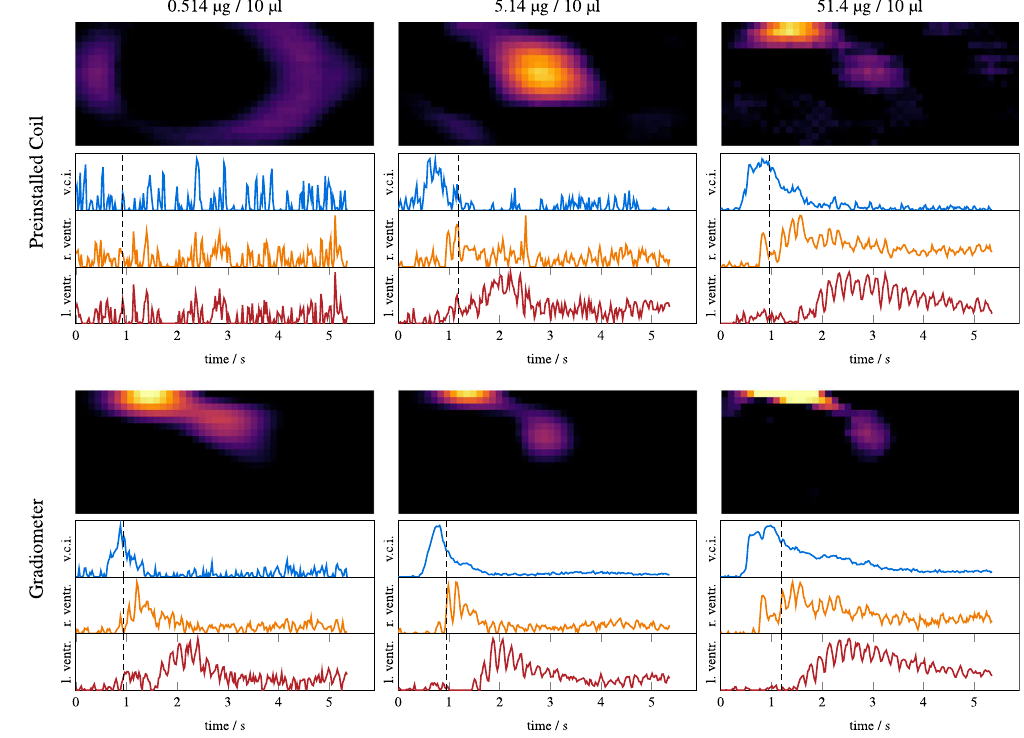
Figure 8. In vivo reconstruction results of the mouse experiment with three different boli: 514 ng/10 μ L (left), 5.14 μ g/10 μ L (middle), 51.4 μ g/10 μ L (right). The results for the preinstalled coil are shown at the top while the results obtained with the gradiometer coil are shown below. For each coil/bolus, a sagittal slice at the time where the SPIONs enter the mouse heart is shown. Additionally, temporal profiles at the vena cava inferior, the left ventricle and the right ventricle are